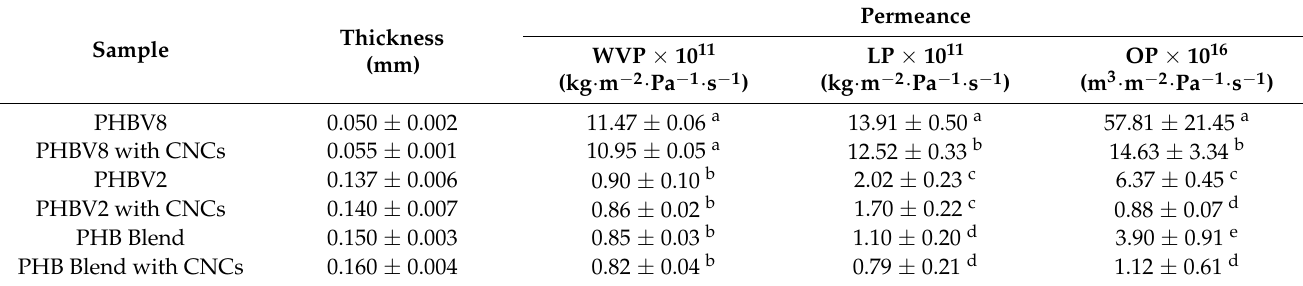
Table 3. Average thickness and permeance values in terms of water vapor permeance (WVP), D -limonene permeance (LP), and oxygen permeance (OP) of the multilayers of poly(3-hydroxybutyrate- co -3-hydroxyvalerate) (PHBV) containing 8 mol.% (PHBV8) and 2 mol.% 3-hydroxyvalerate (PHBV2) and poly(3-hydroxybutyrate) with poly(butylene adipate- co - terephthalate) blend (PHB Blend), with and without cellulose nanocrystals (CNCs).